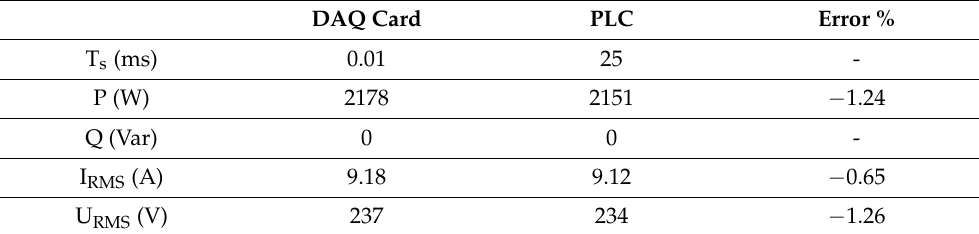
Table 4. Values obtained with DAQ card and PLC measurement.